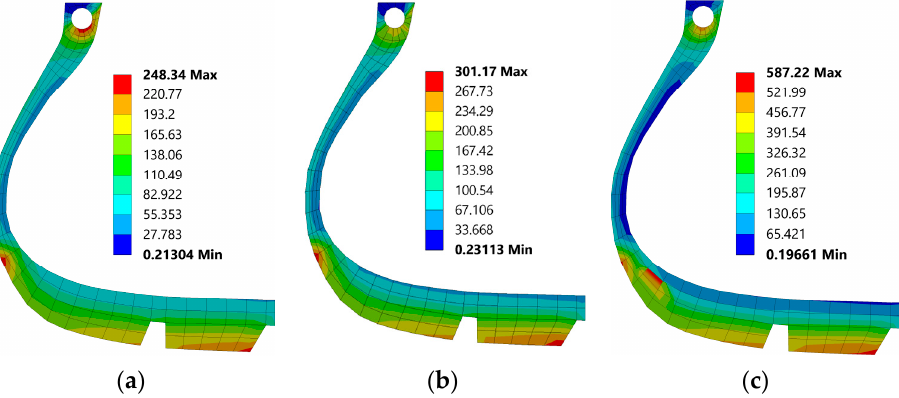
Figure 20. Distribution of heat flux in rubber with different friction coefficients (unit: W/m 3 ): ( a ) 0.1; ( b ) 0.2; ( c ) 0.5.